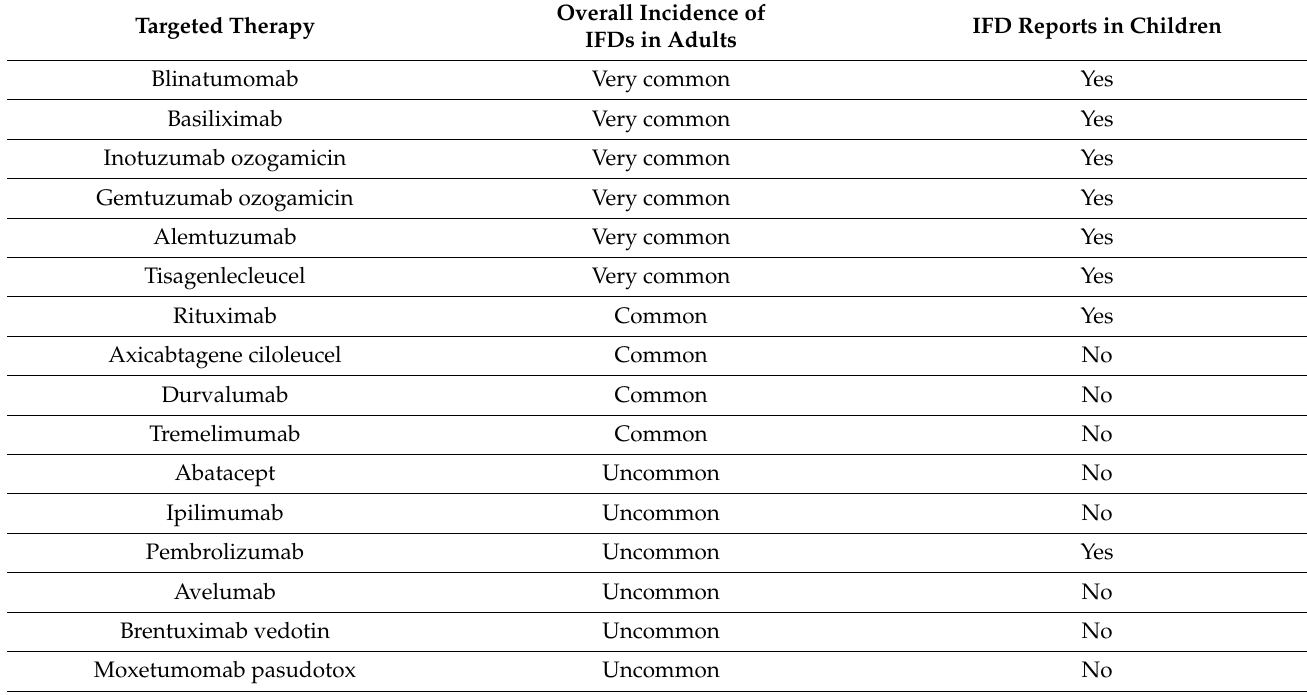
Table 4. Reported overall incidence of IFDs with various targeted